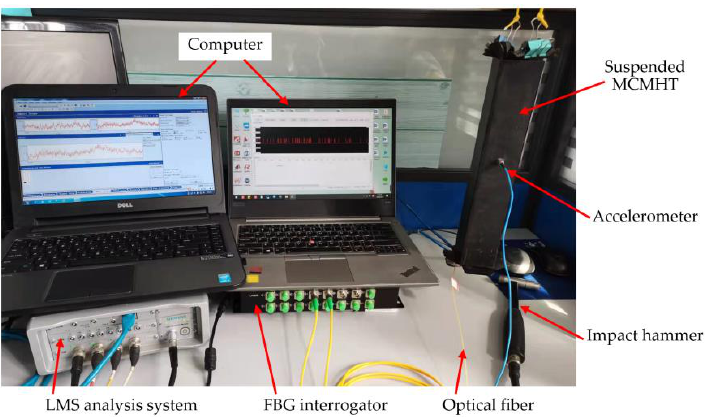
Figure 5. Experimental setup of modal testing.